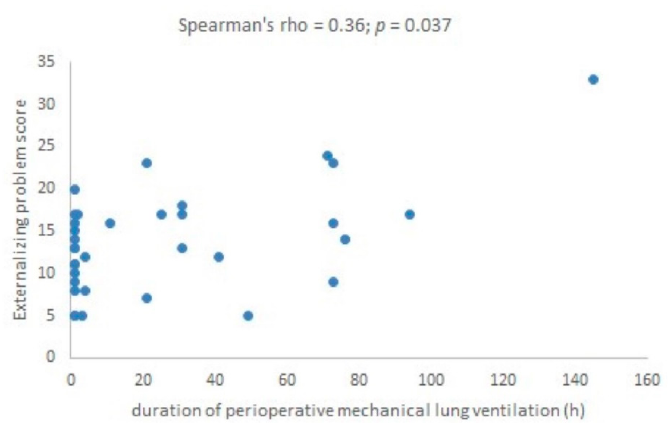
Figure 2. Correlation between the duration of perioperative mechanical lung ventilation and exter- nalizing problem scale scores.